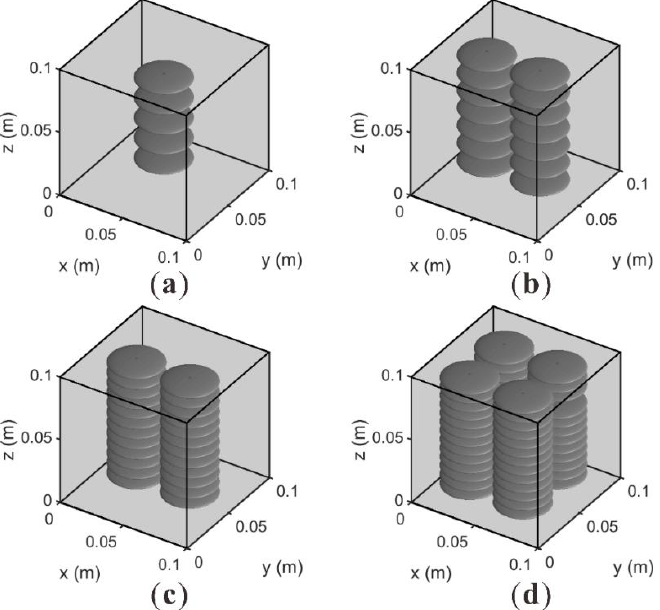
Figure 5. Four 3D models, each being a cube with 0.1 m on its sides, contain penny-shaped spheroid cracks with different fracture densities: 0.04 ( a ), 0.112 ( b ), 0.192 ( c ), and 0.416 ( d ).